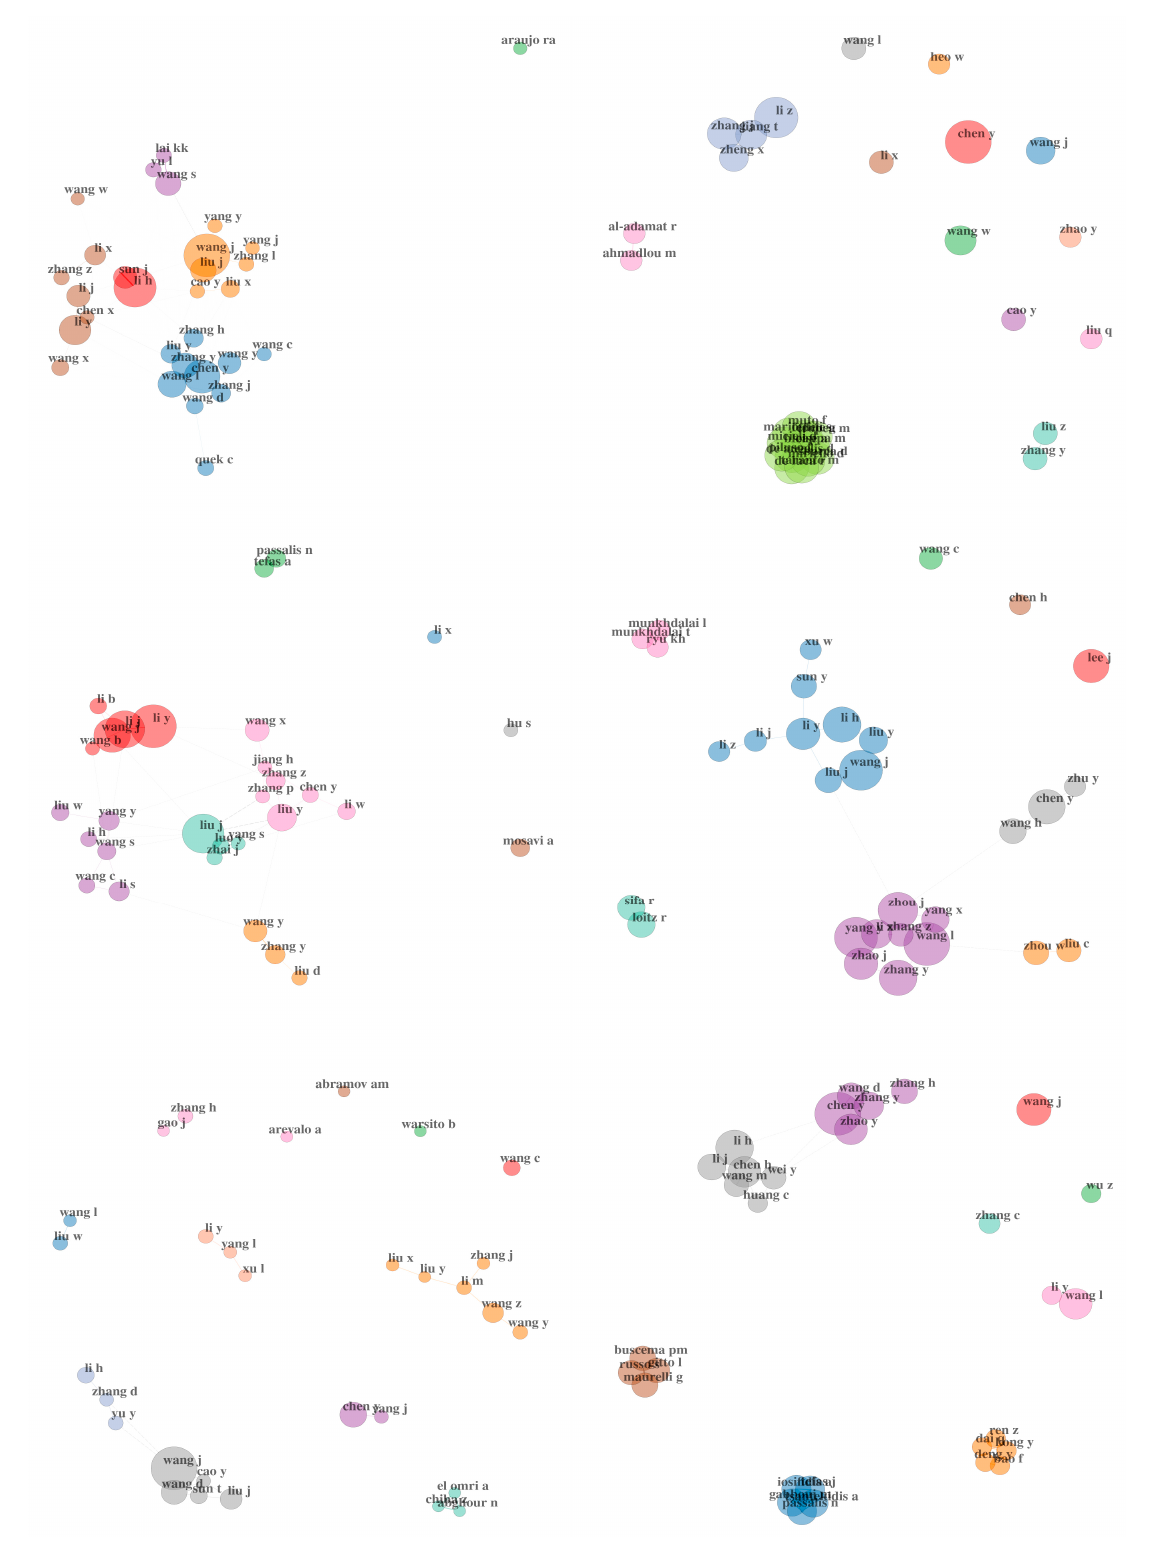
Figure 10. Authors’ collaboration networks, overall period, and per year.